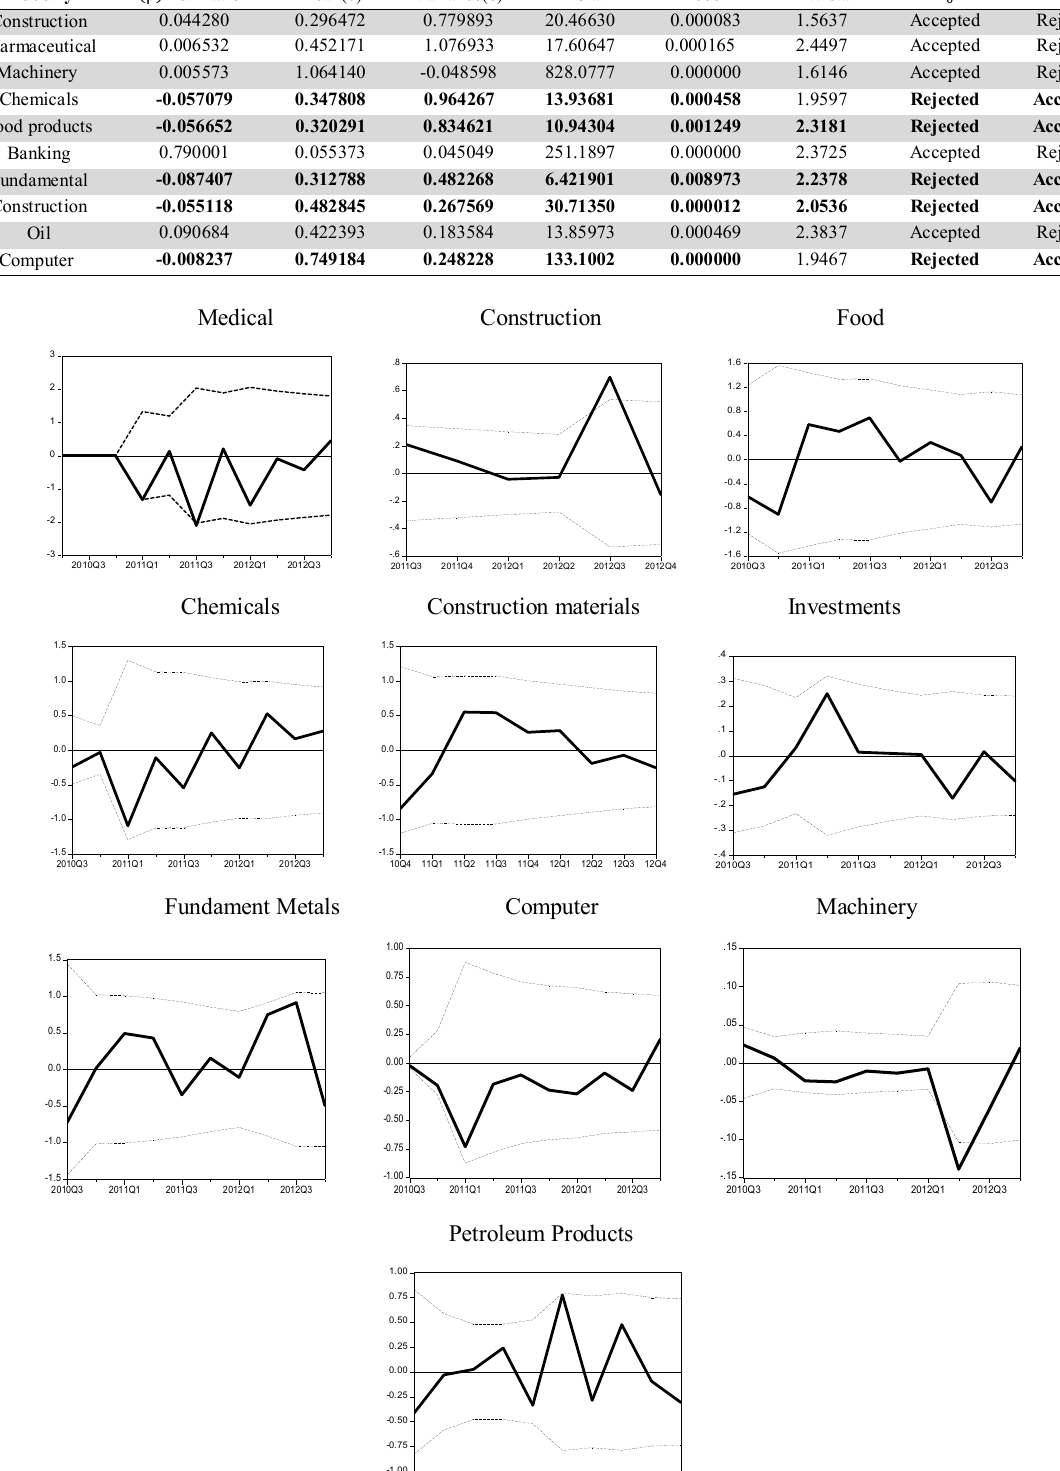
Fig. 1. One step forecasting method estimation